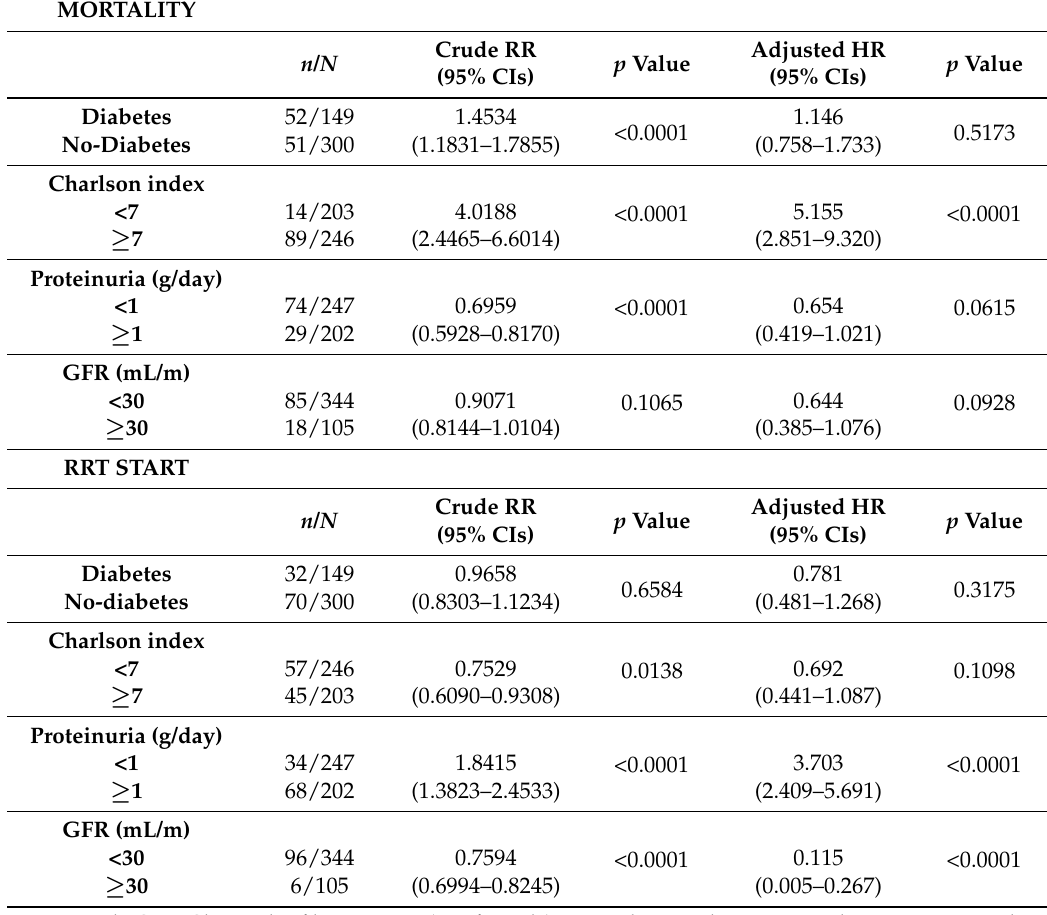
Table 6. Crude and adjusted hazard ratios of mortality and renal replacement therapy start, by diabetes, Charlson index, proteinuria, and GFR (Cox